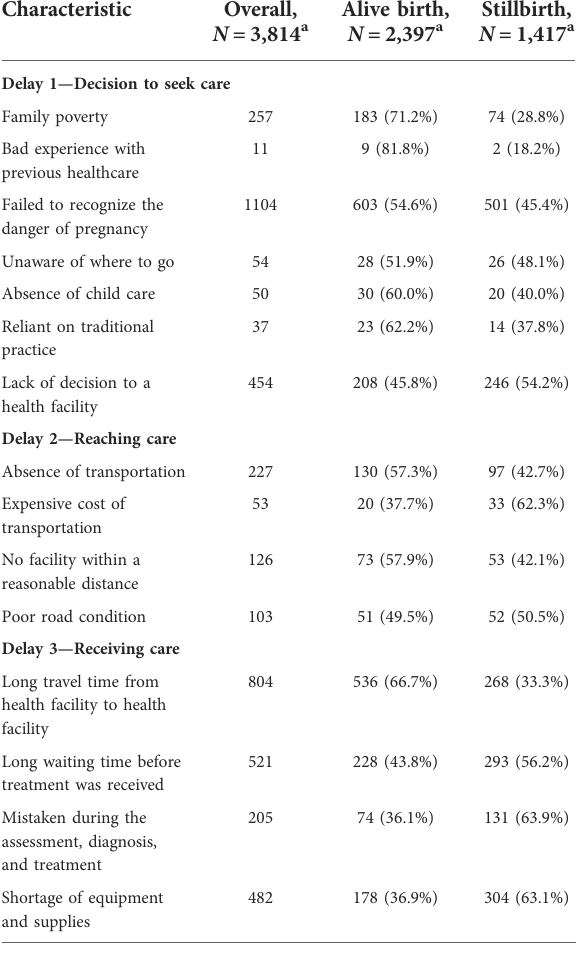
TABLE 6 Delay factors contribute to perinatal death by outcome status of the perinate in Ethiopia, 2021.